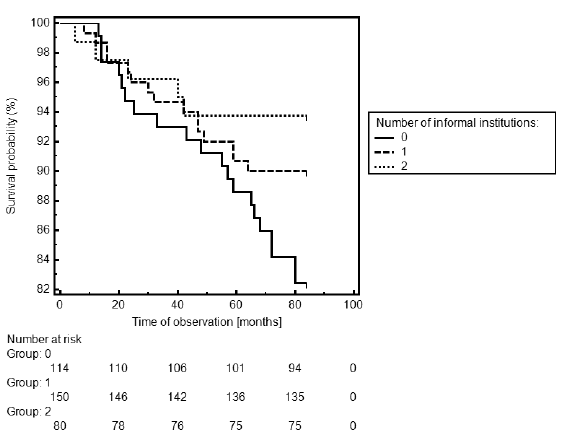
Figure 4. Kaplan-Meier curves for different number of informal institutions pointed out by managers as obstacles to the development of their companies (source : own